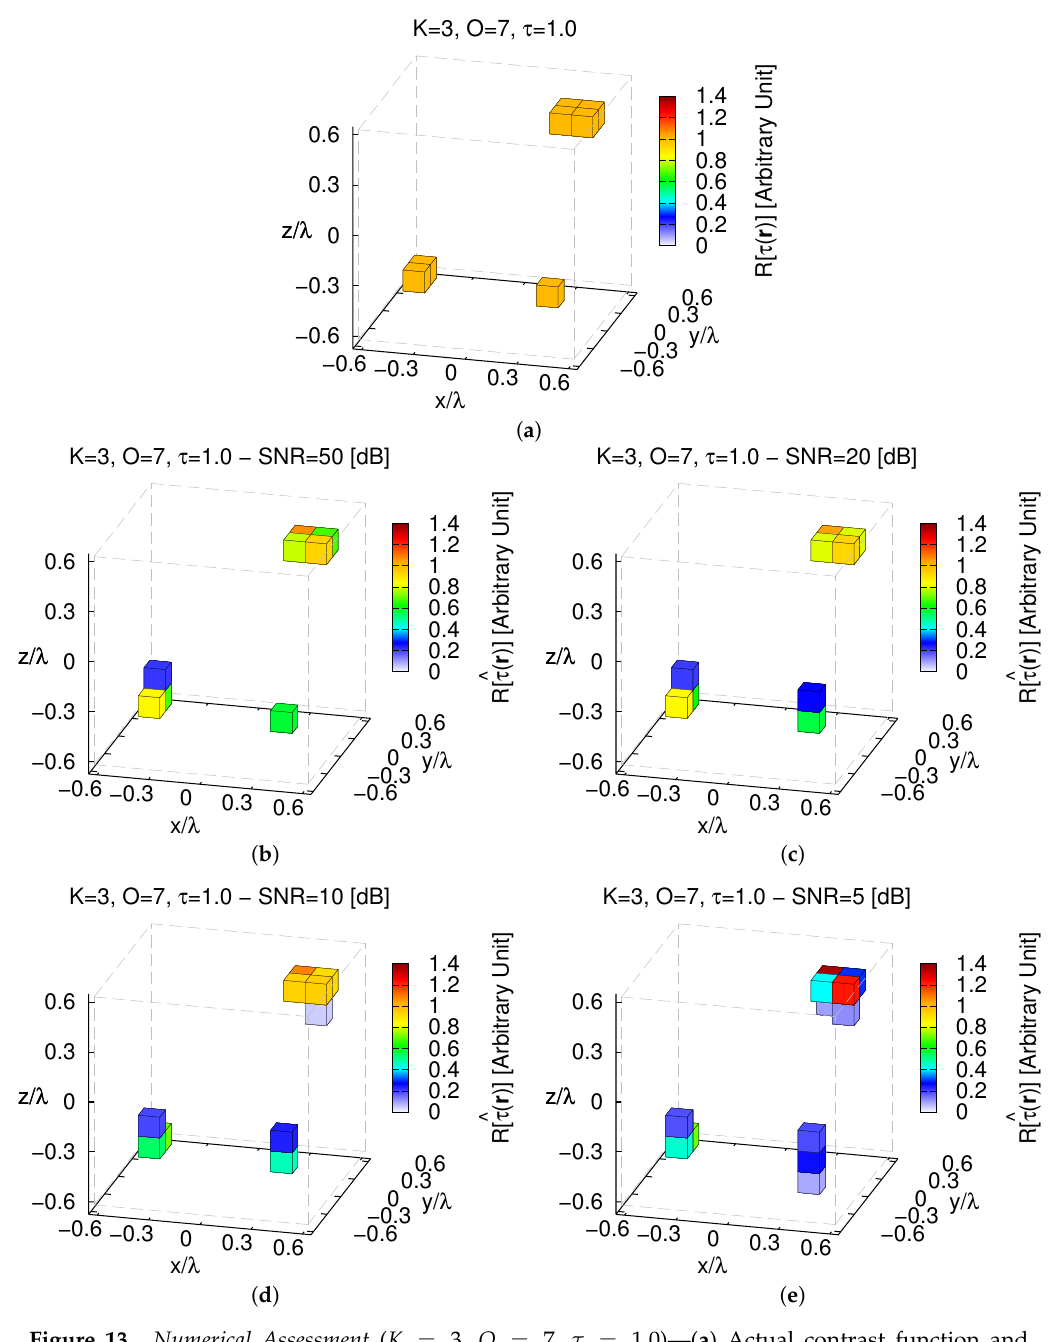
Figure 13. Numerical Assessment ( K = 3, O = 7, τ = 1.0)—( a ) Actual contrast function and MT-BCS reconstructions when ( b ) SNR = 50 [dB] ( (cid:98) τ max = 1.08); ( c ) SNR = 20 [dB] ( (cid:98) τ max = 1.05); ( d ) SNR = 10 [dB] ( (cid:98) τ max = 1.09); and ( e ) SNR = 5 [dB] ( (cid:98) τ max = 1.37).